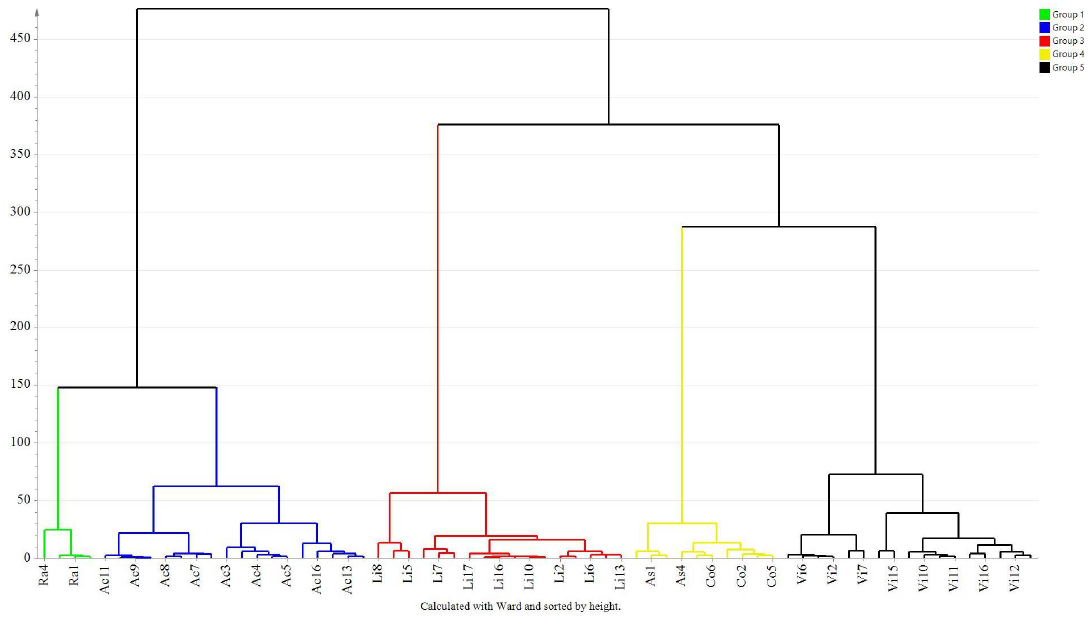
Figure 2. Dendrogram of HCA for honeys. Ra: rapeseed ( Brassica campestris L.); Ac: Acacia ( Robinia pseudoacacia L.); Li: linden ( Tiliaamurensis Rupr.); As: Astragalus ( Astragalus membranaceus (Fisch.) Bunge); Co: Codonoposis ( Codonopsis pilosula (Franch.) Nannf.); Vi: vitex ( Vitex negundo var. heterophylla Rehd.).